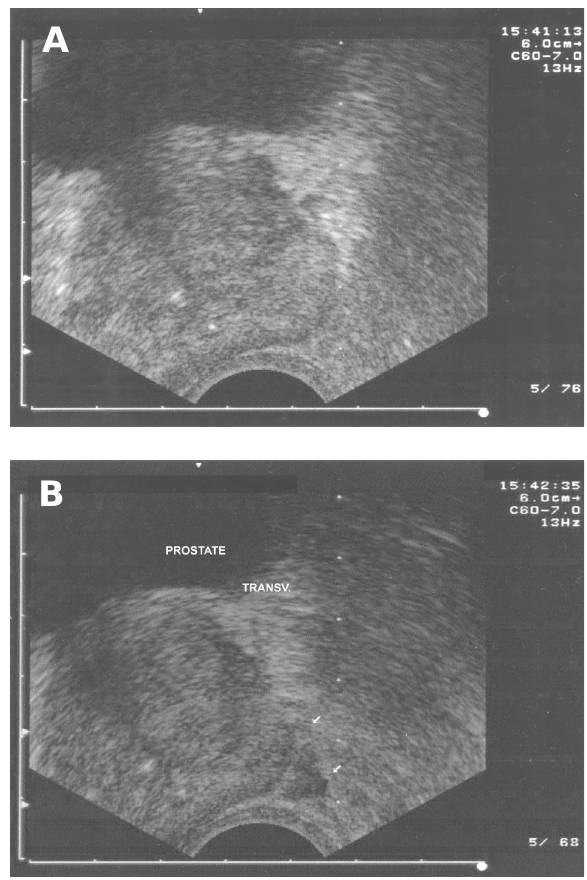
Figure 1 – Ecographic transversal images of the prostate base, pre-injection (A) and post-injection (B) of solution in the peripro- static region.